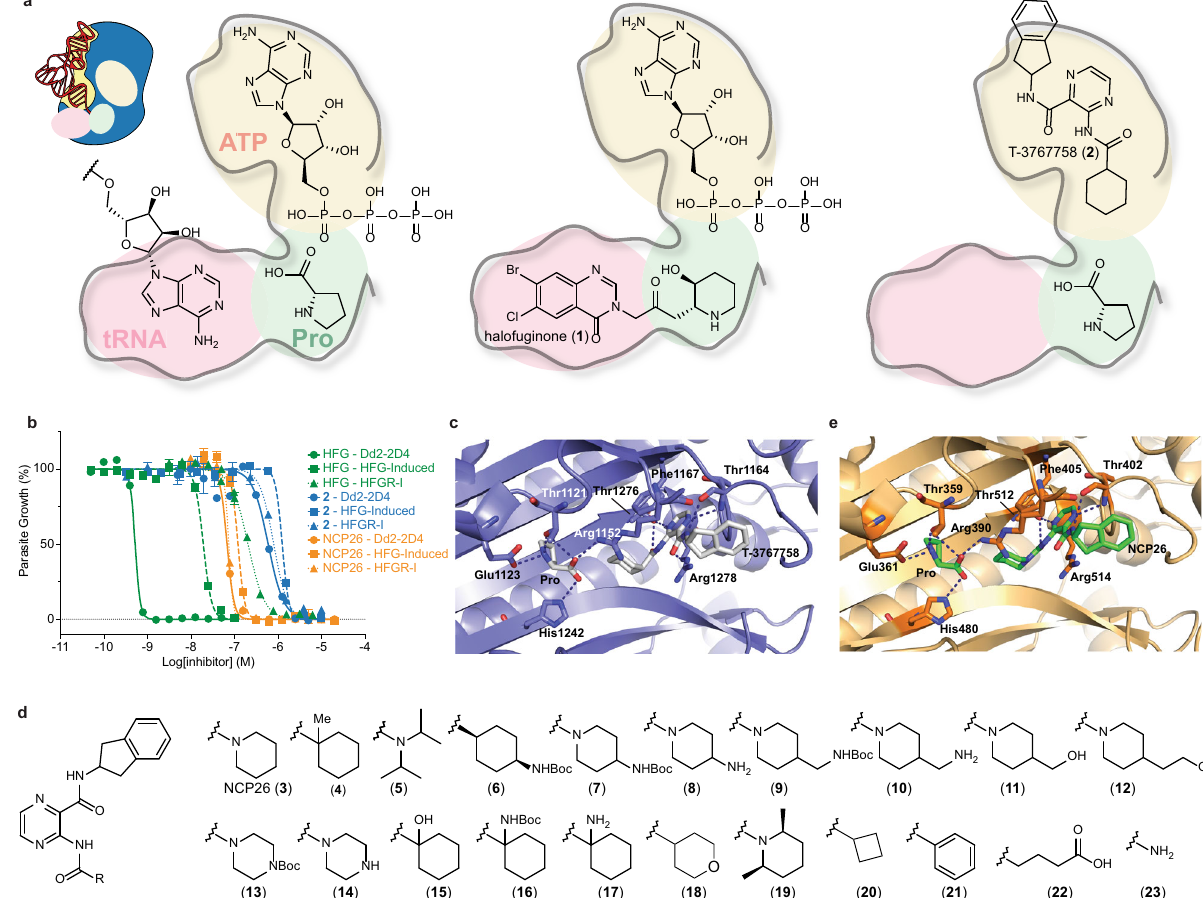
Fig. 1 | ProRS inhibitor design and anti- Plasmodium activity. a Schematic representation of the ProRS active site and binding mode of canonical substrates (proline, ATP, tRNA Pro ), halofuginone ( 1 ), and T-3767758 ( 2 ). The active site of ProRS constitutes three distinct substrate pockets, which bind the terminal adenosine (A76) residue of tRNA Pro (red), proline (green), and ATP (yellow). Halofuginone binds in the tRNA Pro and proline-binding pockets and requires the presence of ATP for tight binding (ATP-uncompetitive), while compound 2 tar- gets the ATP-binding pocket and requires the presence of proline for tight binding (proline-uncompetitive). b In vitro activity of halofuginone (HFG, green), 2 (blue), and NCP26 ( 3 , orange) against wild-type (Dd2-2D4, solid line), halofuginone-induced (HFG-induced, dashed line), and HFGR-I (dotted line) P. falciparum strains.Asexualbloodstage(ABS) P.falciparum parasitesweretreated